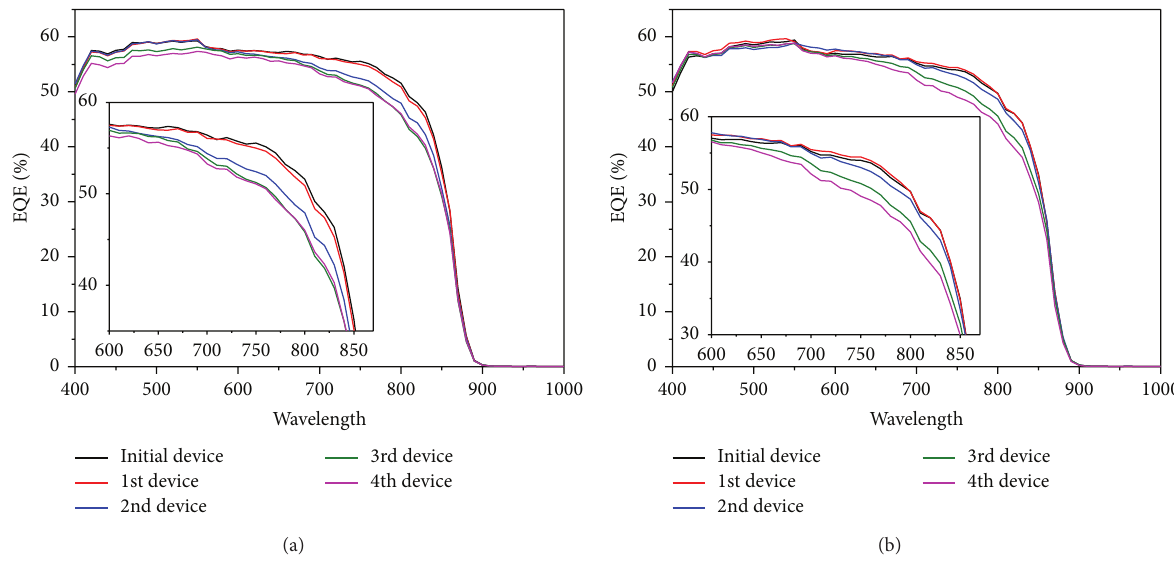
Figure 5: EQE responses of solar cell grown on new and recycled GaAs substrate; (a) before light soaking test (b) with light soaking test of 267 hours. (The inset figure is the magnification of EQE curve at wavelength from 600 to 870 nm.)